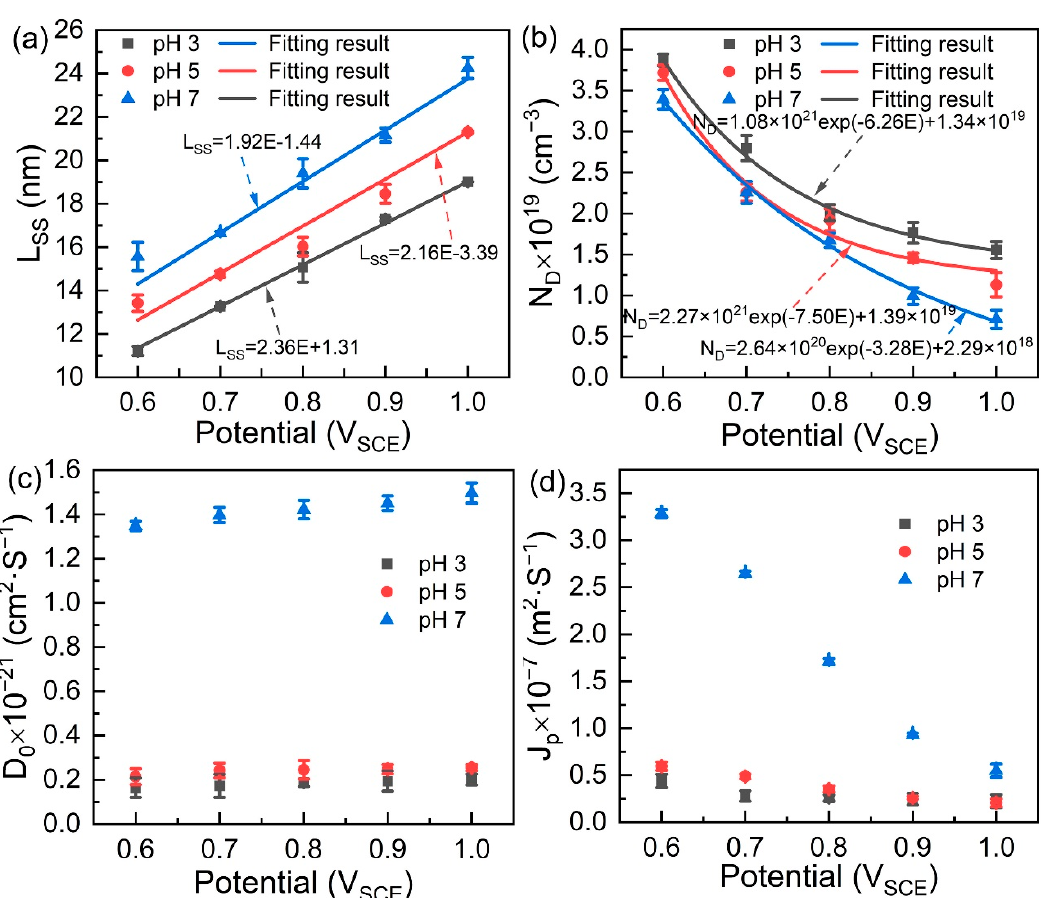
Figure 7. Calculated ( a ) thicknesses (L SS ), ( b ) donor densities (N D ), ( c ) vacancy diffusion coefficients (D O ), and ( d ) vacancy fluxes (J P ) of the passive films formed on LPBFed Ti–6Al–4V, under different potentiostatic polarization potentials (0.6, 0.7, 0.8, 0.9 and 1.0 V SCE ), in Hank’s solution at different pHs.